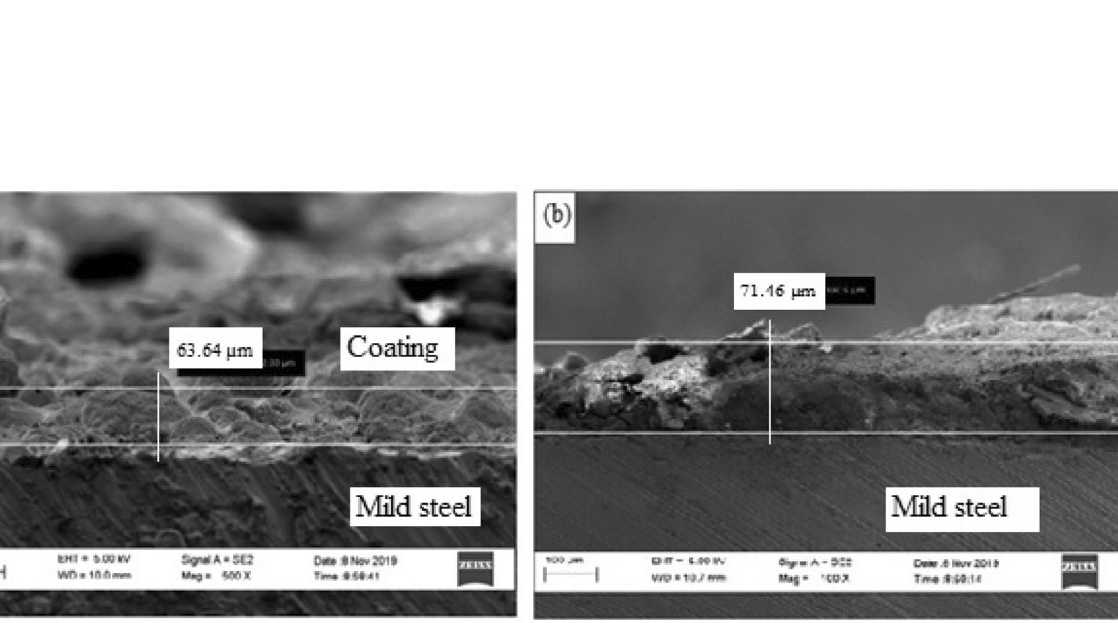
Figure 14. SEM cross-sectional view of the sample coated and heated at 200 °C ( a ) before corrosion and ( b ) after